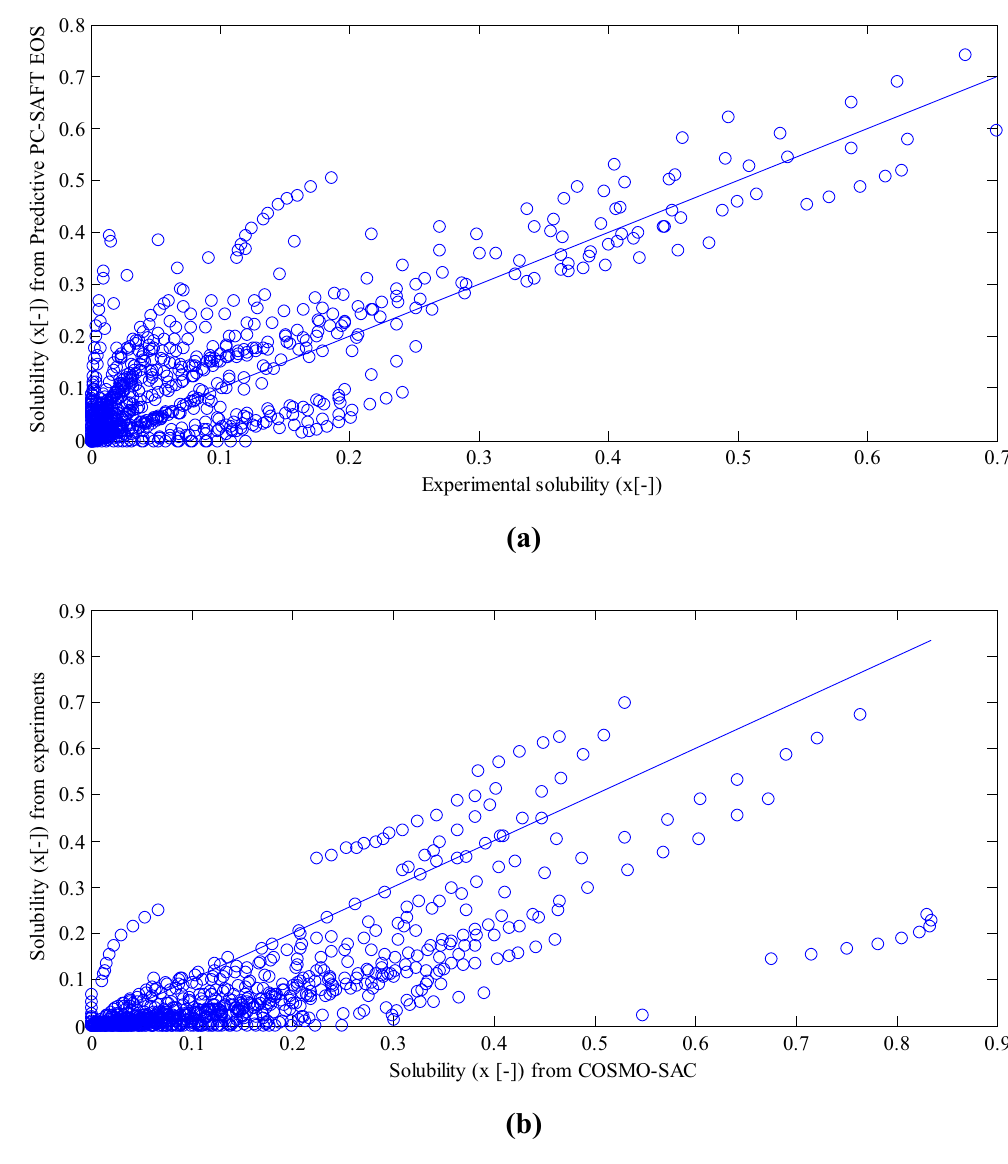
Figure 5. .(a) Parity plot of experimental solubility data (mole fraction) in pure solvents compared to calculated solubility data (mole fraction) from predictive PC-SAFT EOS results (b) Parity plot of experimental solubility data (mole fraction) in pure solvents compared to calculated solubility data (mole fraction) from COSMO-SAC model 16